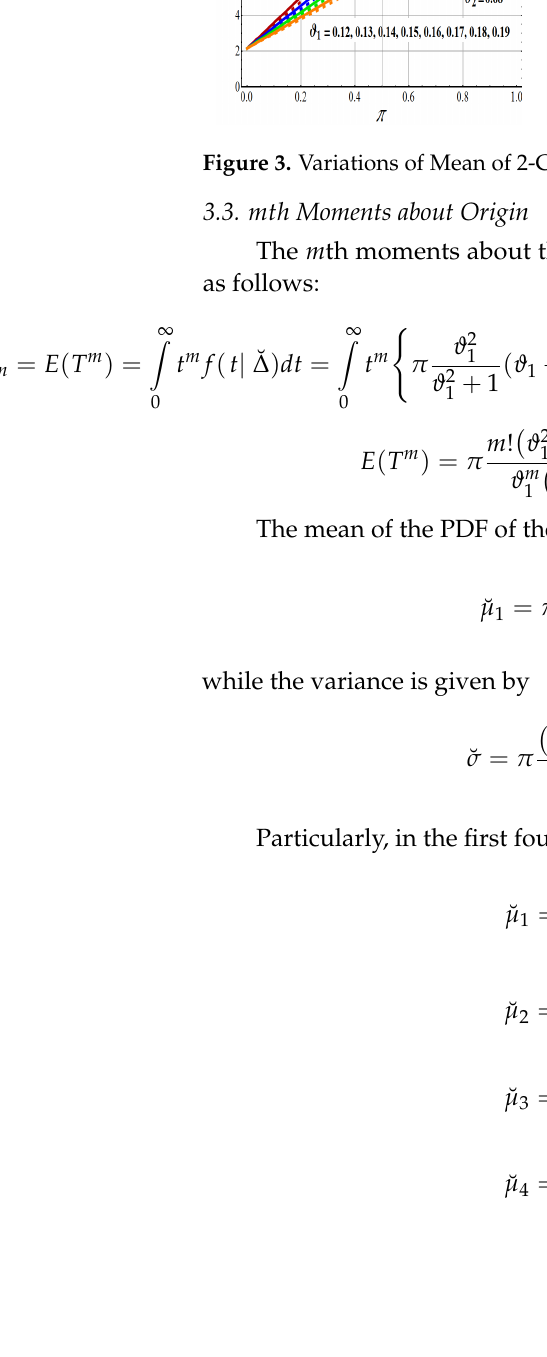
) ). j (cid:21)(cid:1)) for various parameter j